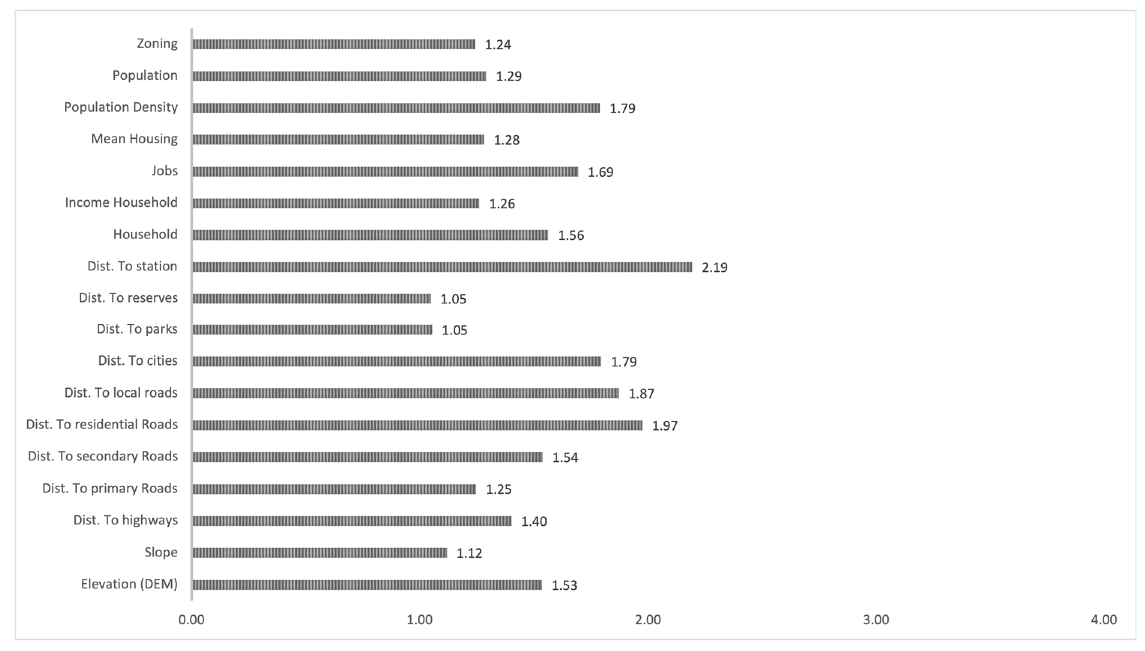
Figure 2. List of selected variables for models after second VIF test run.